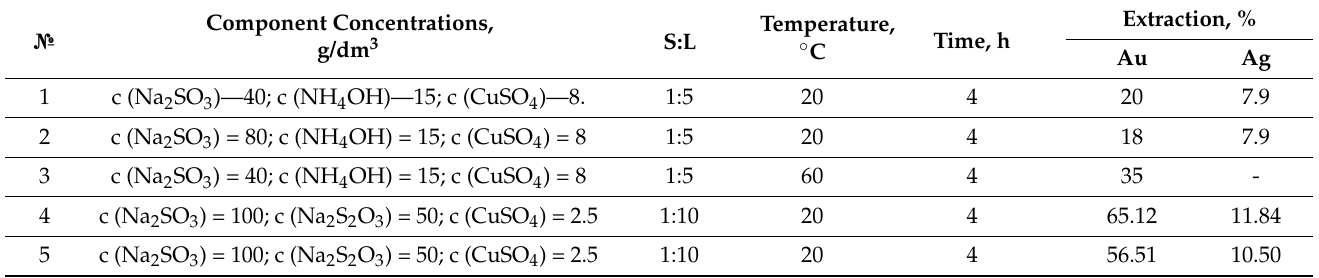
Table 5. Leaching process results for residue after thermochemical activation based on sulfur compounds.